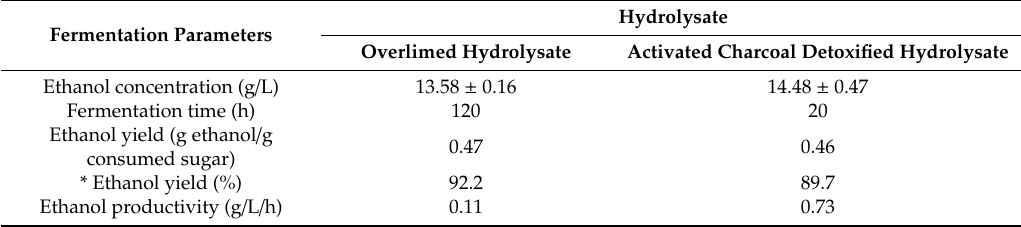
Table 2. Parameters of the EOP hydrolysate fermentation with Escherichia coli